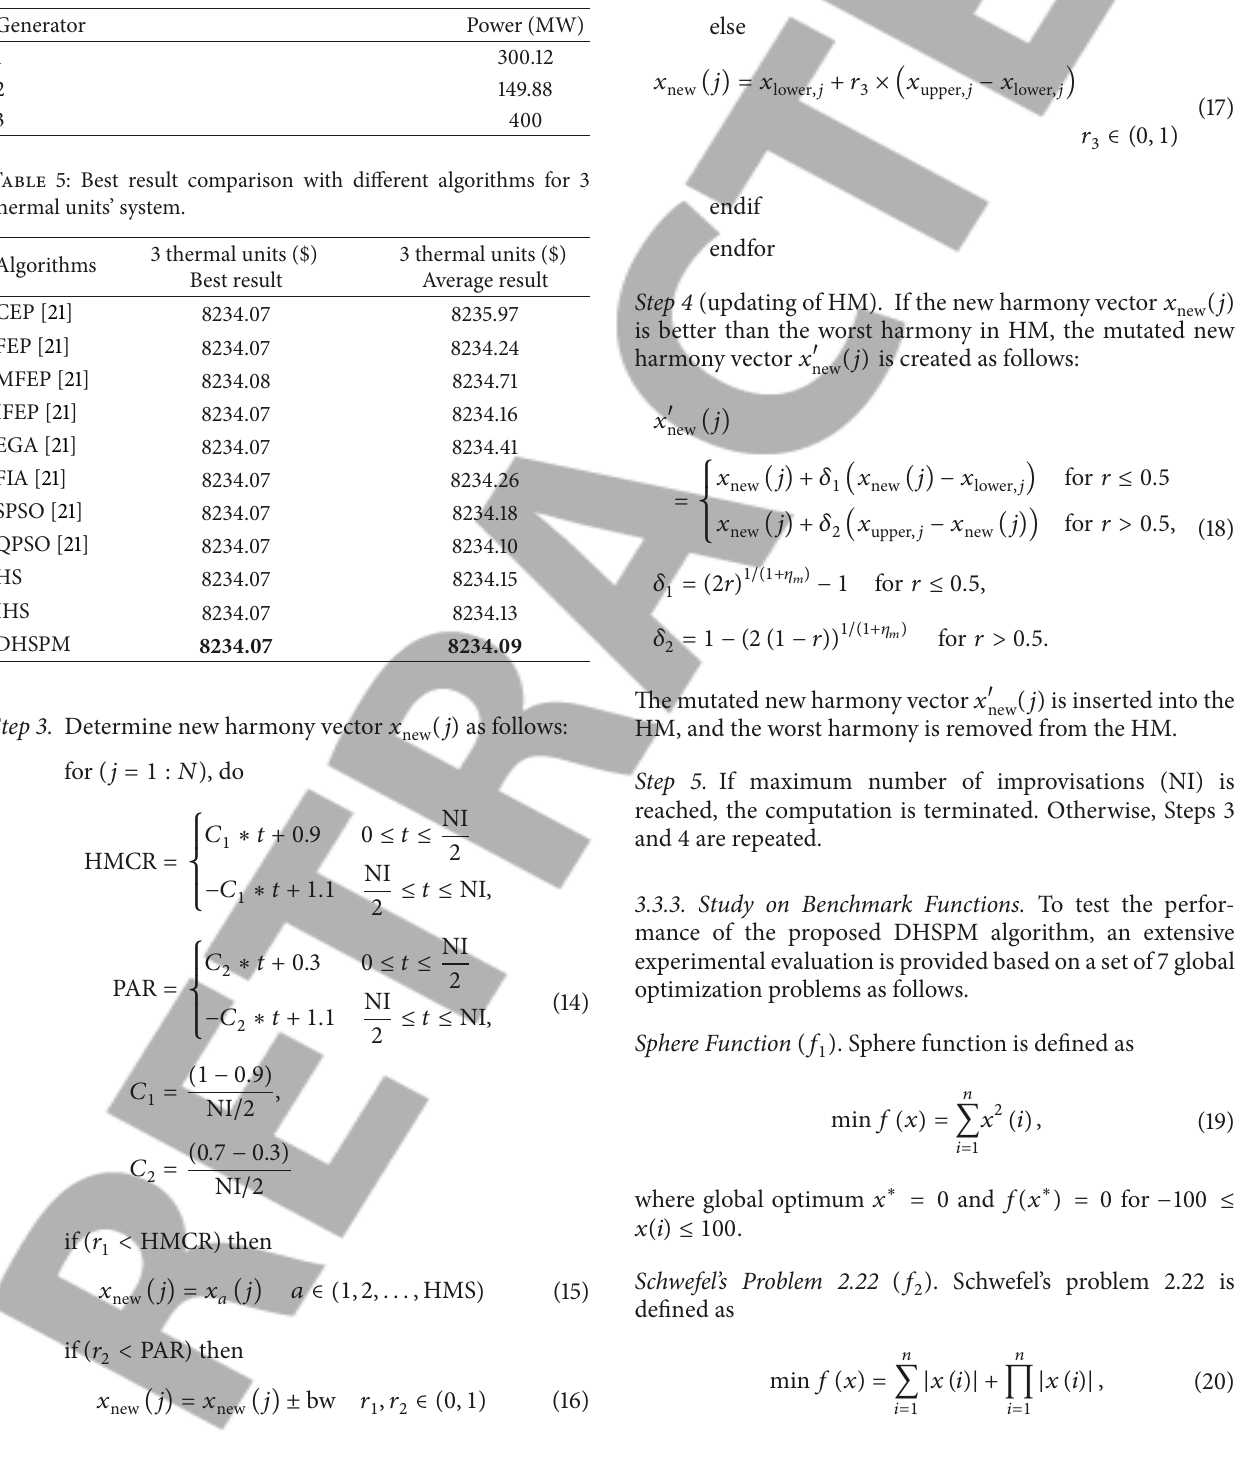
Table 4: 3 thermal units’ test results.